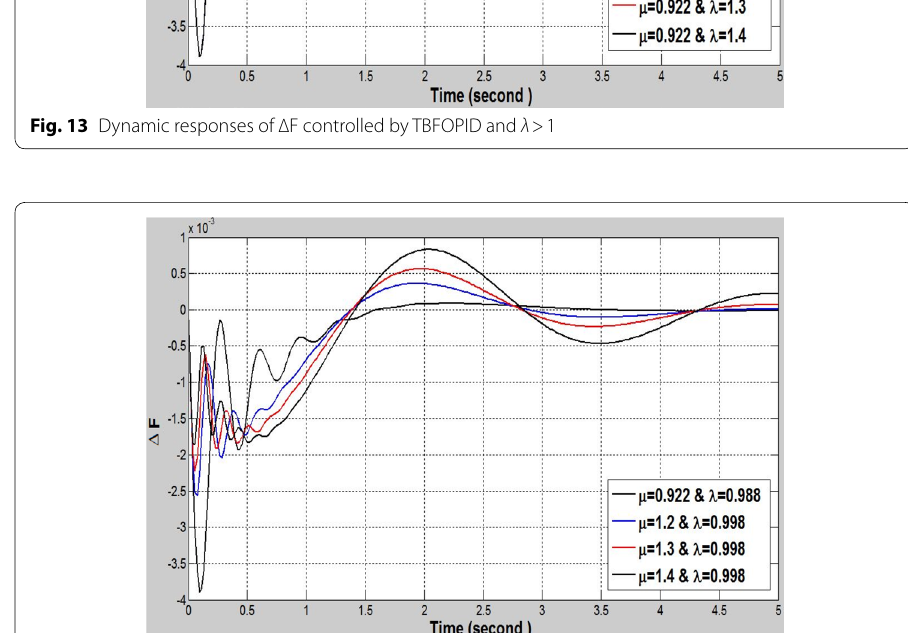
Fig. 14 Dynamic responses of ∆F controlled by TBFOPID and μ >